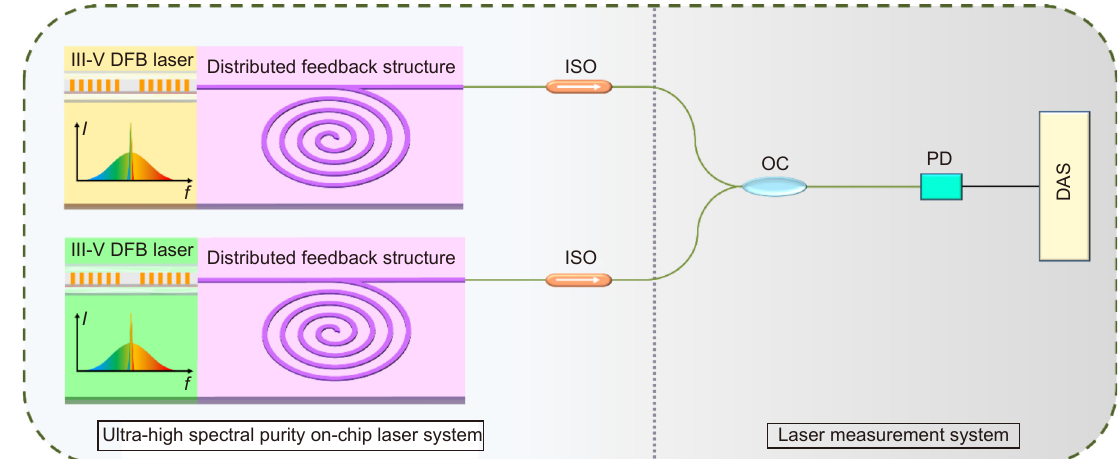
Fig. 3 | An on-chip laser system based on weak external distributed perturbation. ISO: optical isolator; OC: optical coupler; PD: photoelec- tric detector; DAS: data acquisition